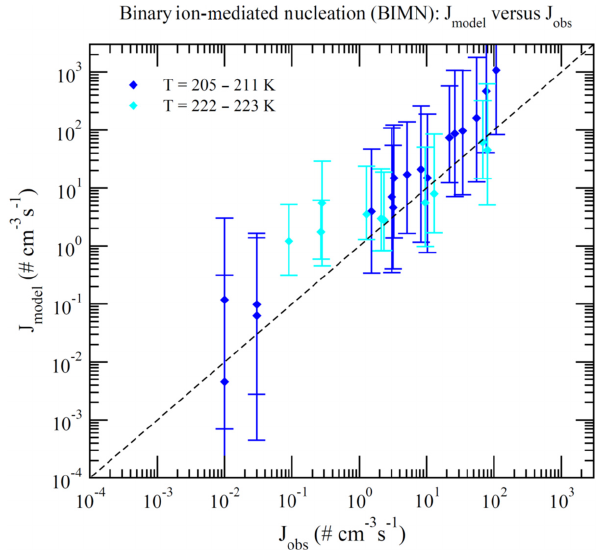
Figure 1. Model-predicted ( J model ) versus observed ( J obs ) nucle- ation rates under BHN conditions (no ionization, [ NH 3 ] < 0 . 1ppt) of CLOUD measurements reported in Table S1 of Dunne et al. (2016). The data points are grouped according to temperatures as specified in the legend. Vertical error bars show the range of J model calculated at 50% and 200% of measured [H 2 SO 4 ], corresponding to the uncertainties in measured [H 2 SO 4 ] ( − 50%, + 100%). Error bars associated with the uncertainties in measured [NH 3 ] ( − 50%, + 100%) and J obs (overall a factor of 2) are not shown.